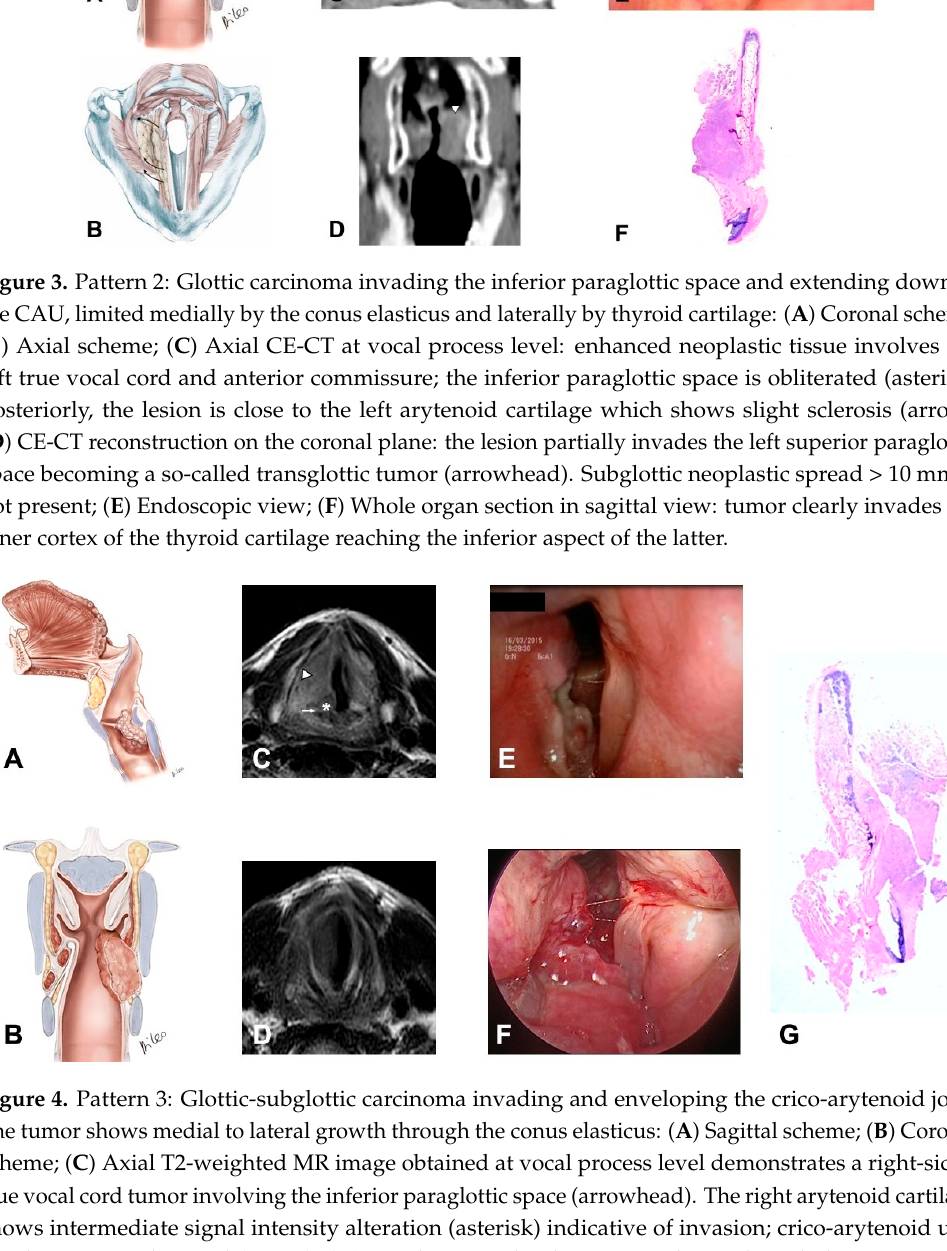
arytenoid unit involvement is observed (arrow); D ) Axial T2-weighted sequence shows the subglottic involvement is observed (arrow); ( D ) Axial T2-weighted sequence shows the subglottic spread of